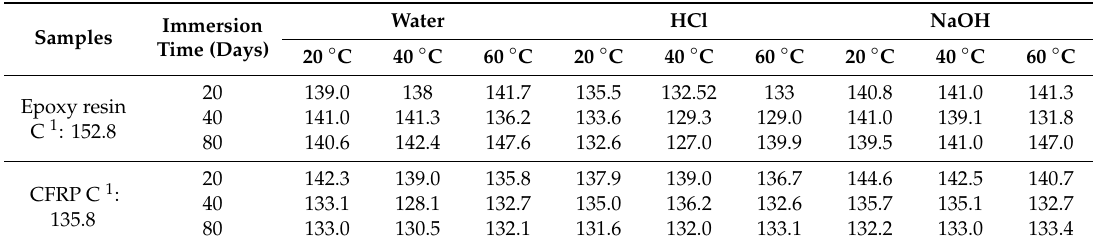
Table 2. Glass transition temperature ( T g ± 1 ◦ C) of epoxy resin and CFRP composites in di ff erent immersion